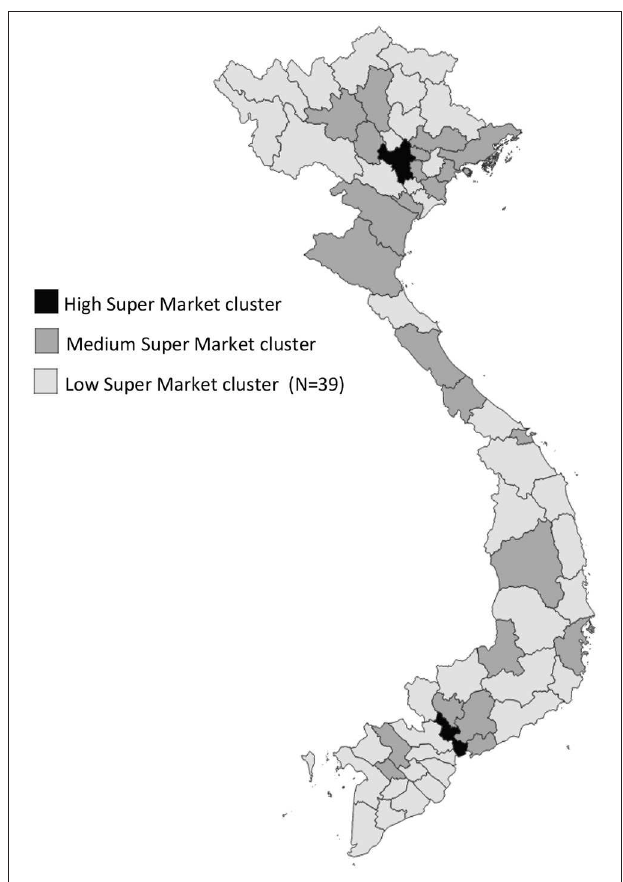
FIGURE 2 | Spatial distribution of clusters.